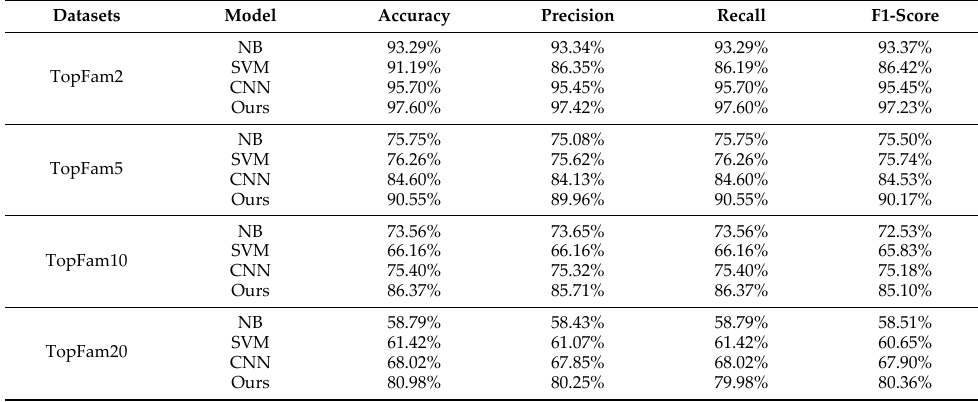
Table 3. Experimental results on four datasets.